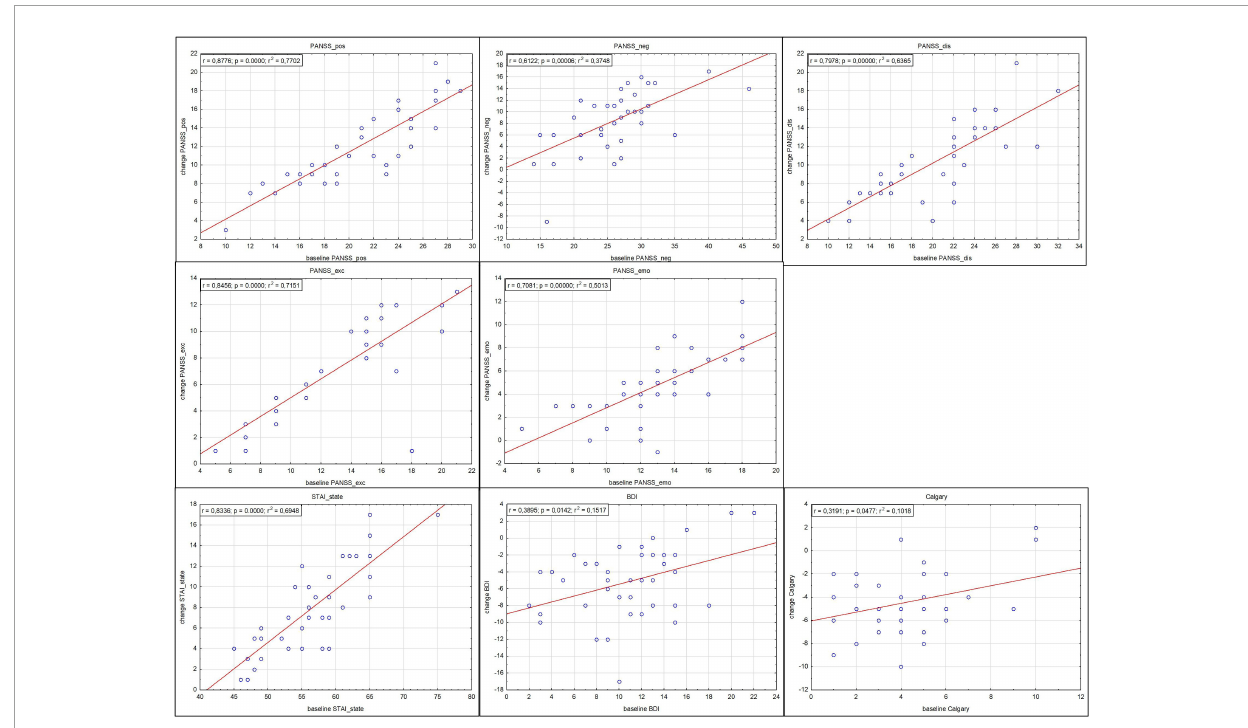
FIGURE1 Correlations between subscale drops (indicating improvement) after 12 weeks of treatment and subscale values at admission.